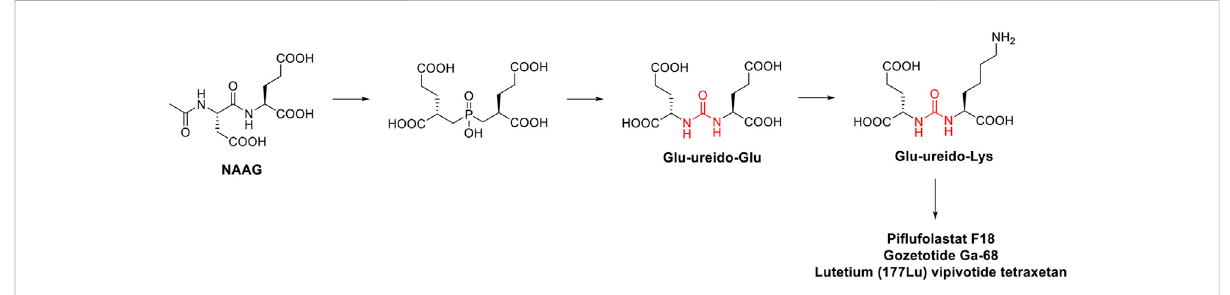
FIGURE 6 Medicinal chemistry rationale that was leading to the development of pi fl ufolastat F18, gozetotide Ga-68 and lutetium (177Lu) vipivotide tetraxetan starting from